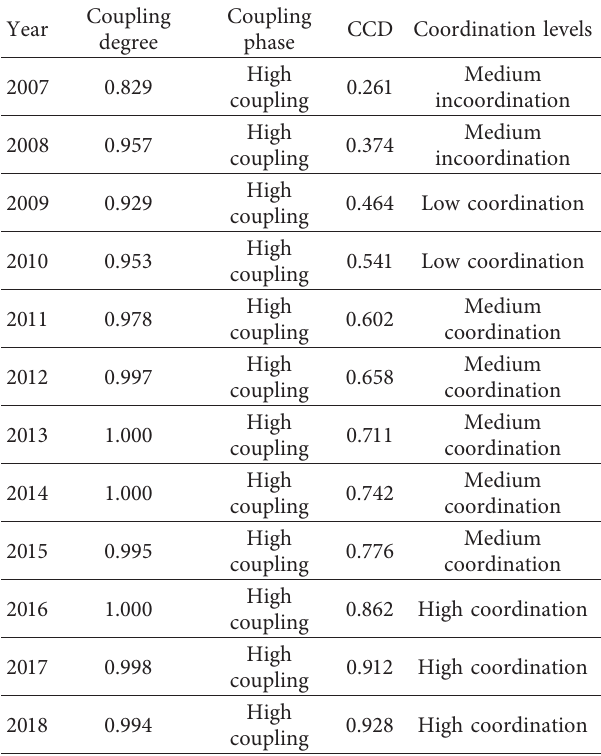
Figure 1: Relative development levels. Table 7: Coupling degrees, CCDs, and their